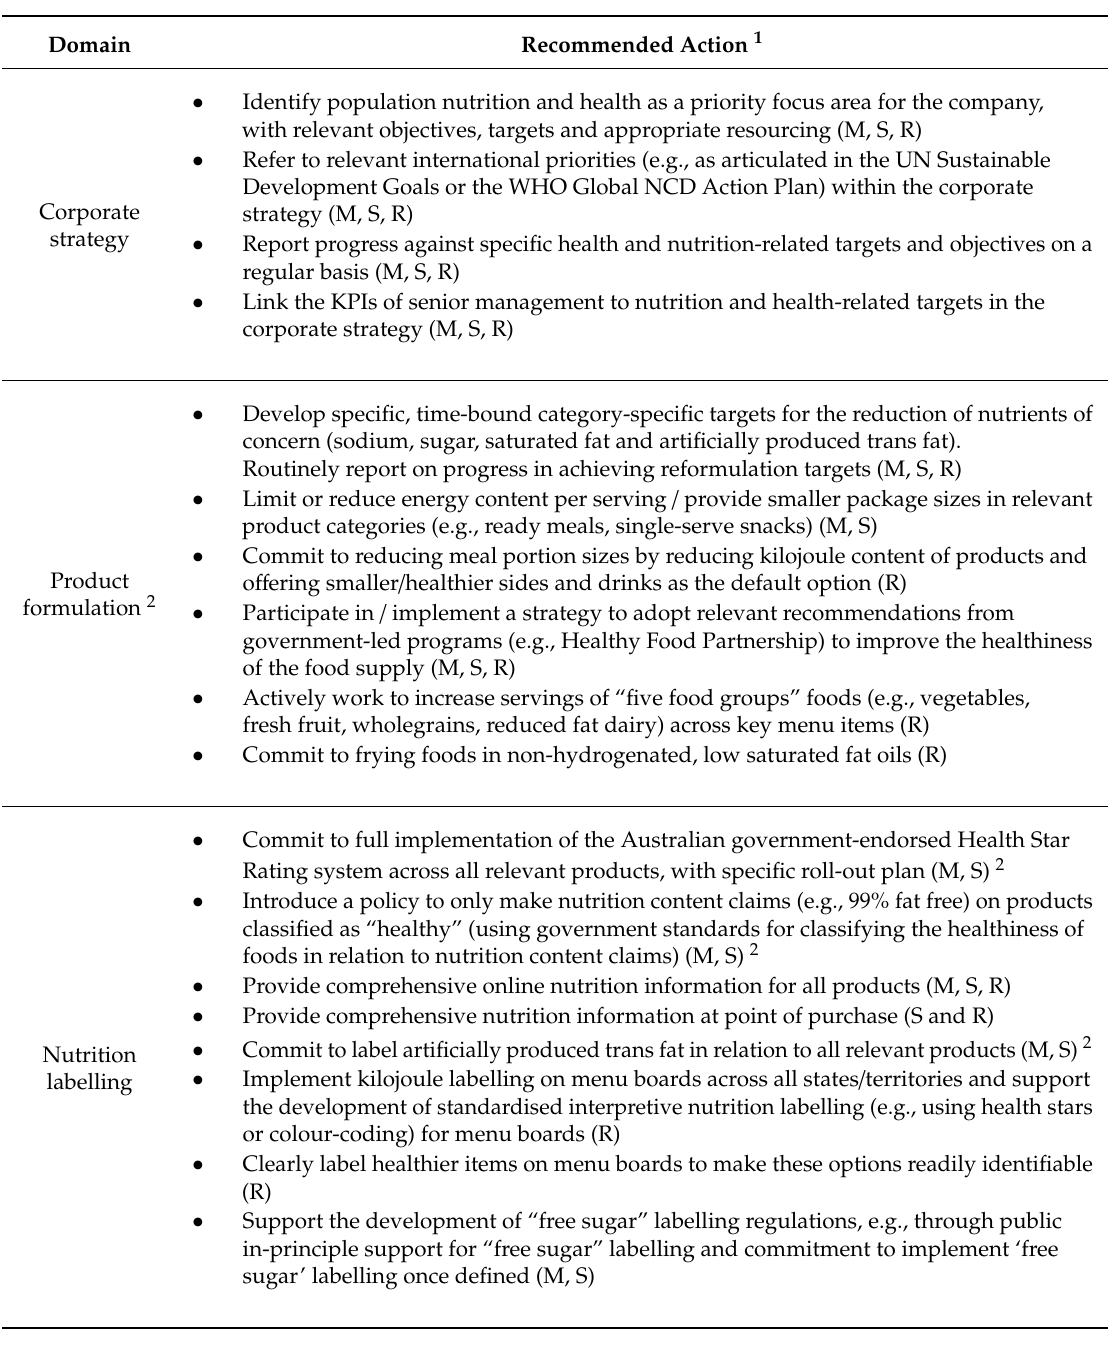
Table 3. Recommended actions for companies included in BIA-Obesity Australia 2018